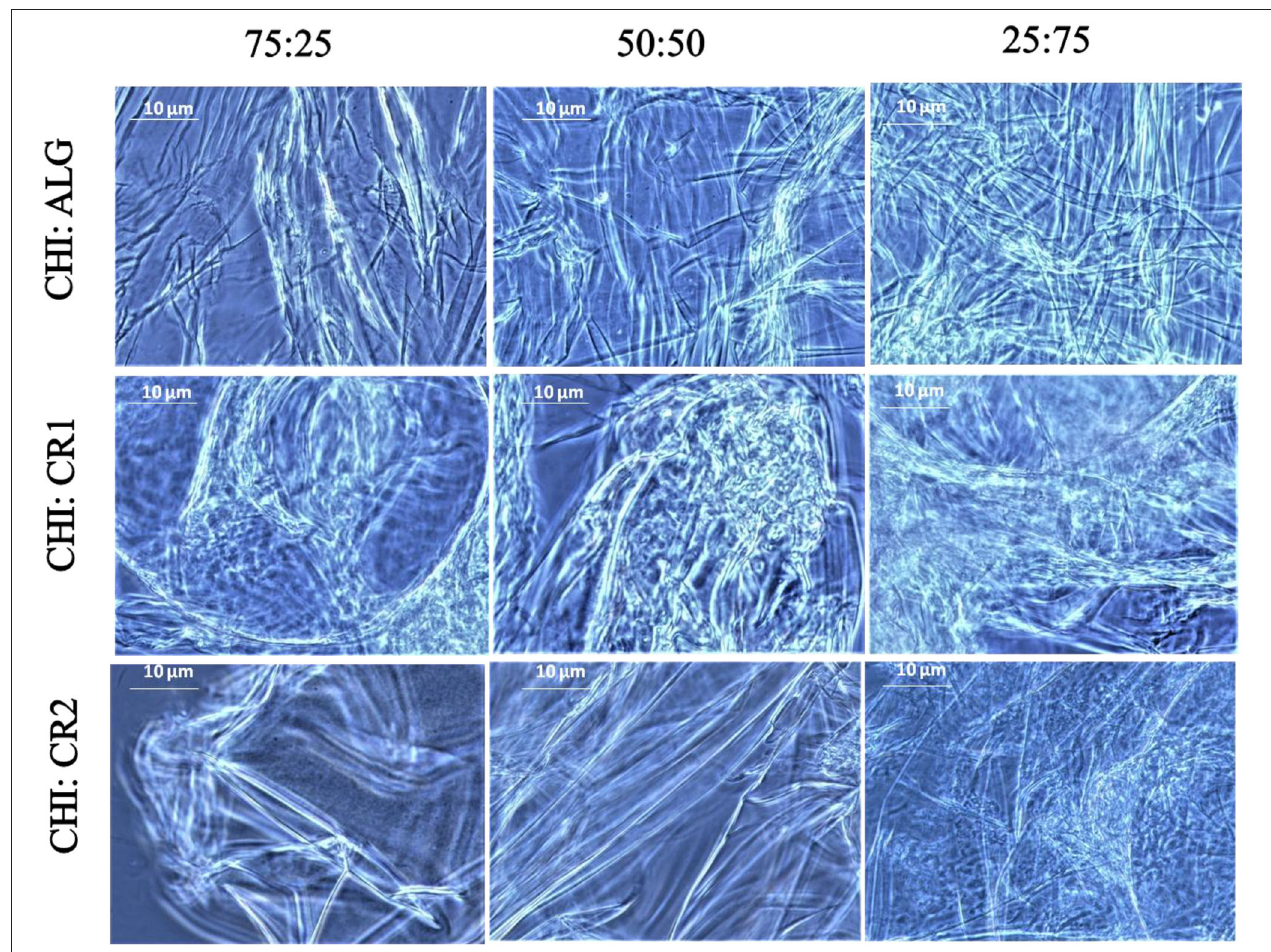
FIGURE 2 | Optical micrograph of the complexes CHI:ALG, CHI:CR1, and CHI:CR2 at different polymer ratio (75:25, 50:50, and